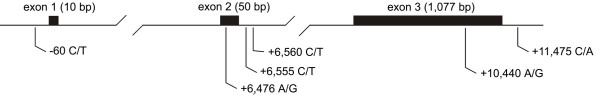
Schematic overview of the CCR7 gene located at chromosome 17q12 – q21.2. The enlarged areas represent the three exons with their flanking regions that have been subjected to sequence analysis. The positions of the observed SNP are given in relation to the first base of exon 1 which has been set to +1.